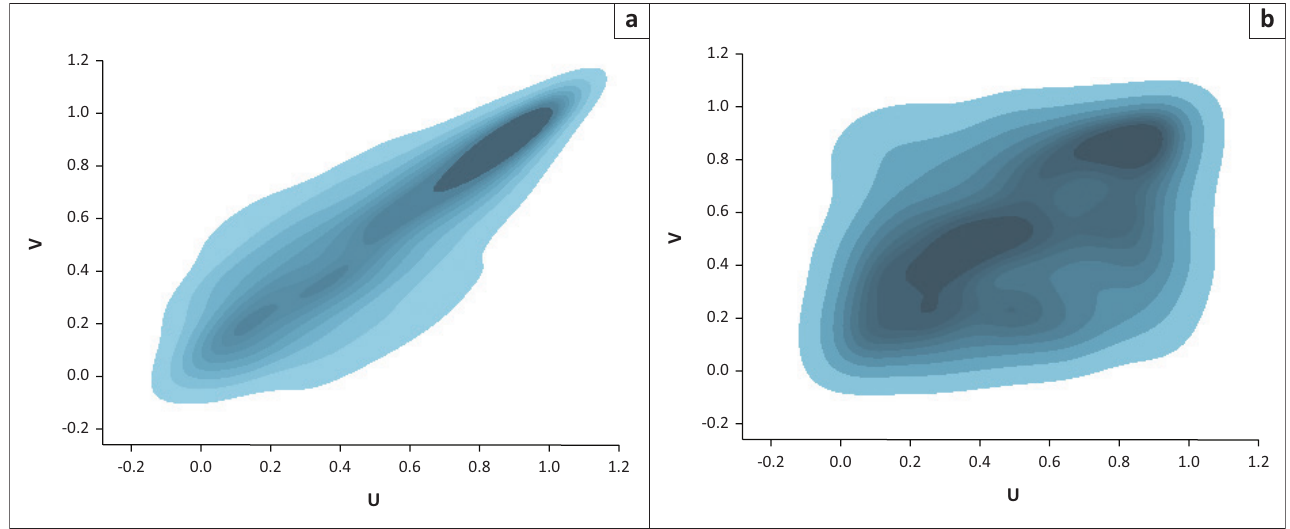
FIGURE 5: Pearson linear correlation between selected emerging market currency-pairs calculated over a rolling 6-month period (a–d).